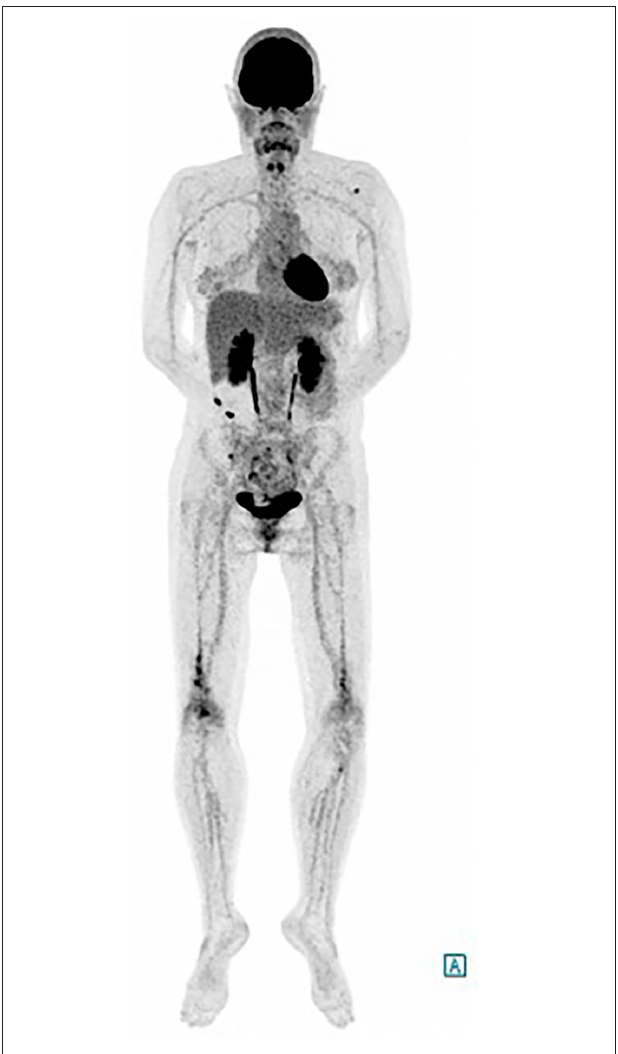
FIGURE 2 | FDG-PET/CT, showing multifocal radiotracer uptake in the long bone marrow predominantly on the distal half of the femurs.